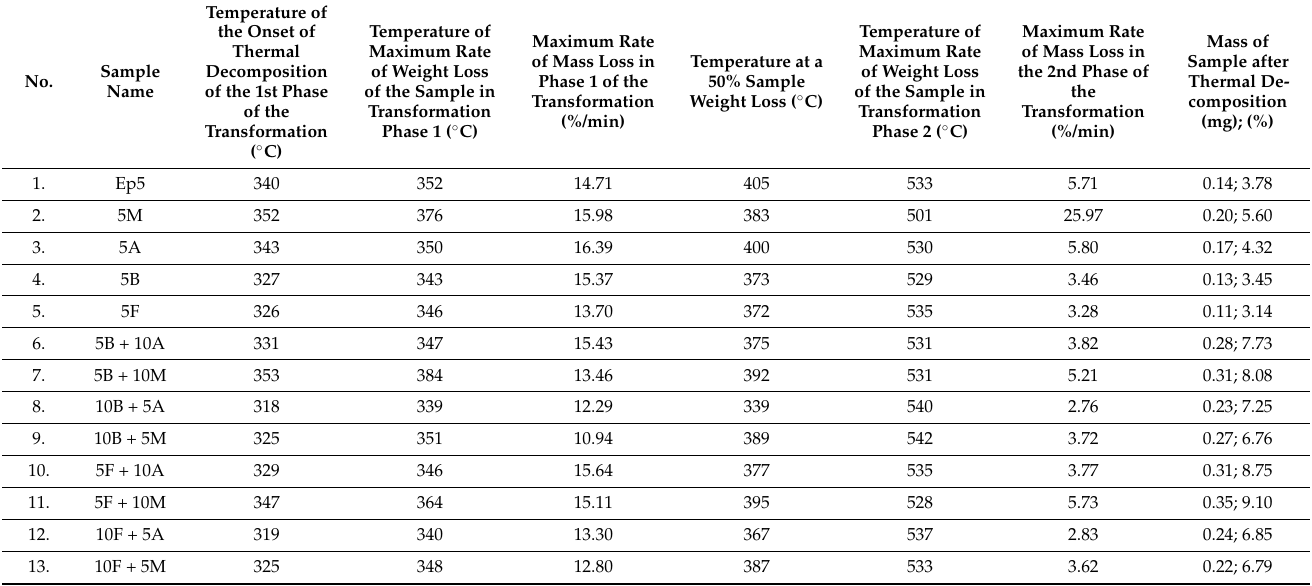
Table 4. Results of thermogravimetric tests on modified and unmodified epoxy resins.